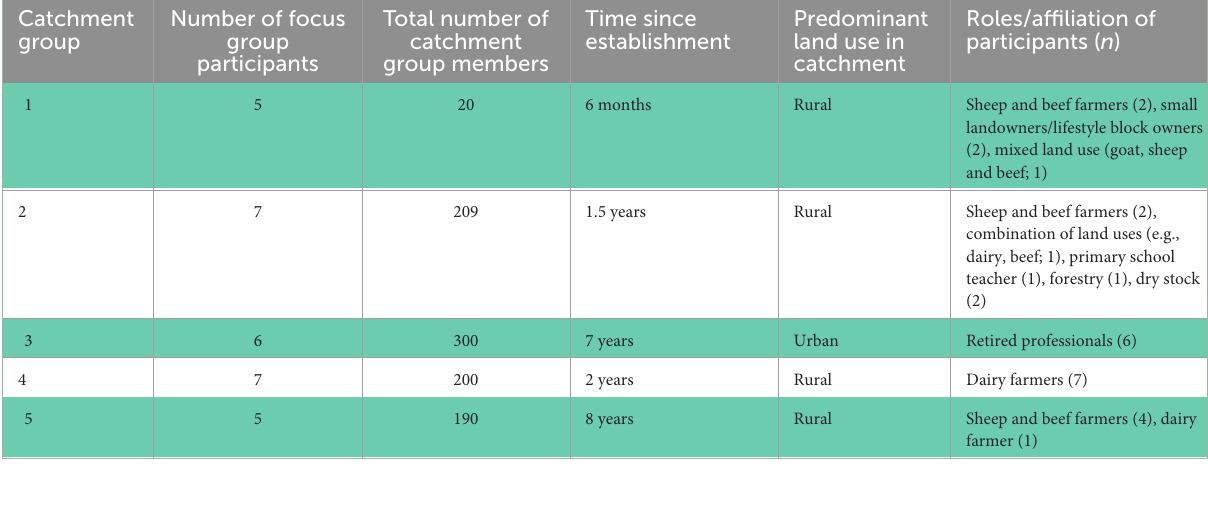
TABLE 1 Summary of catchment groups used in this study.